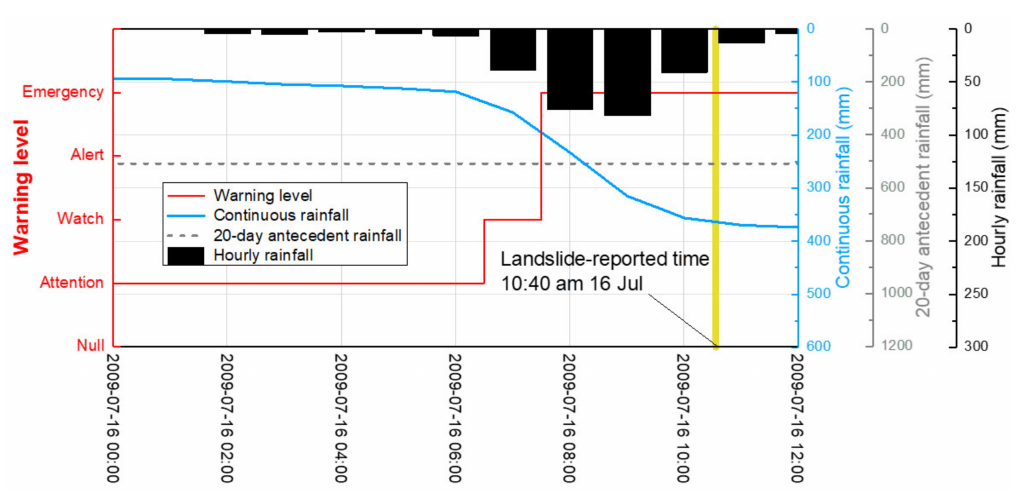
Figure 14. Progression of changes in rainfall and the corresponding warning levels over a specific time scale leading to Landslide occurrence 2 in Figure